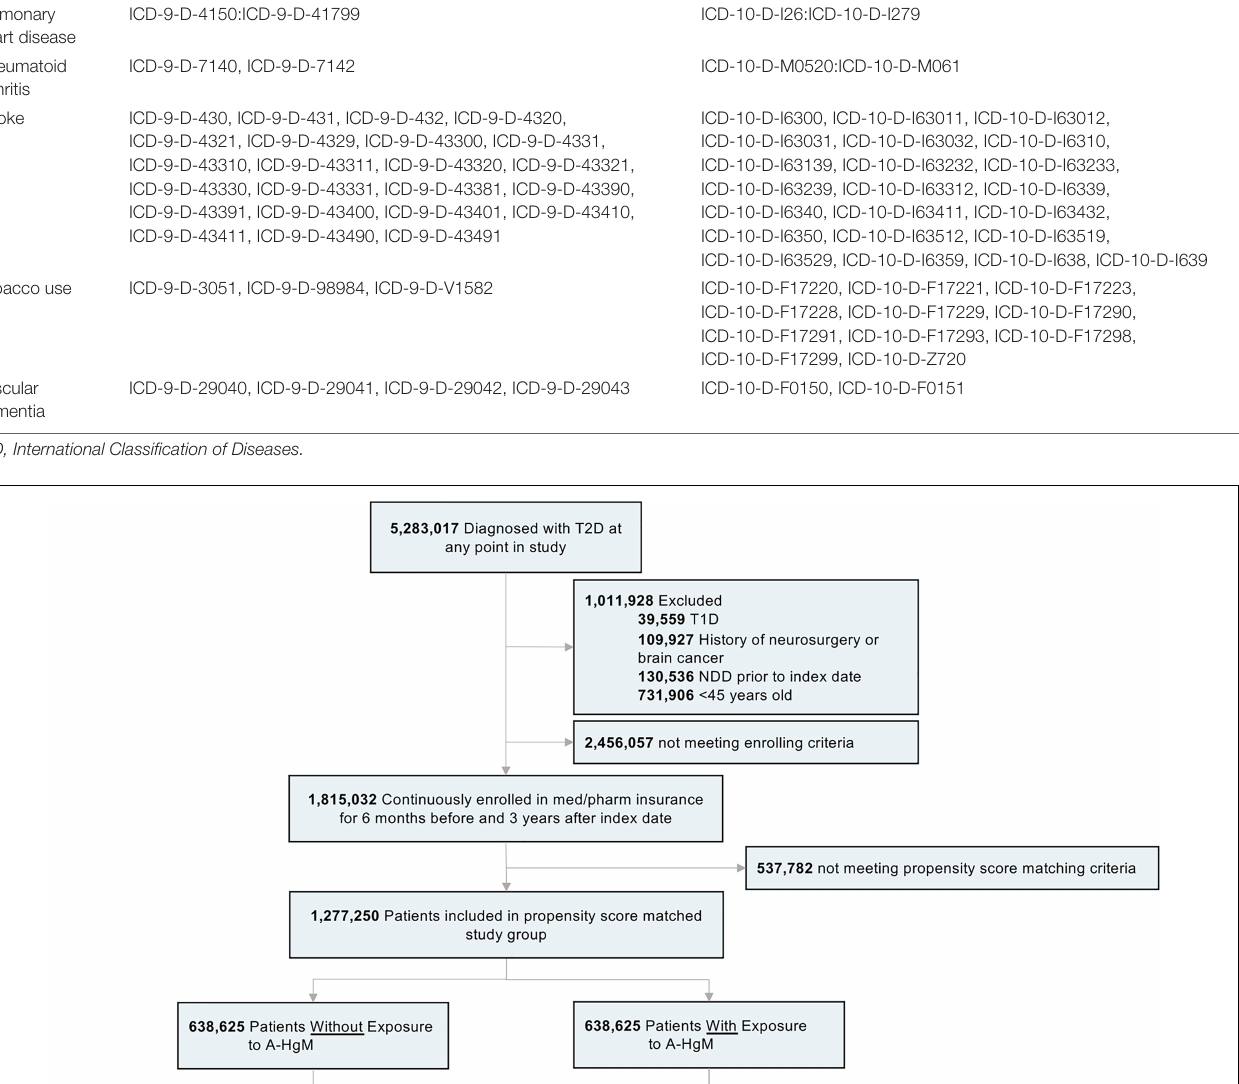
over time and dipeptidyl peptidase-4 (DDP-4) inhibitors slowed the rate of memory decline with the greatest benefit in